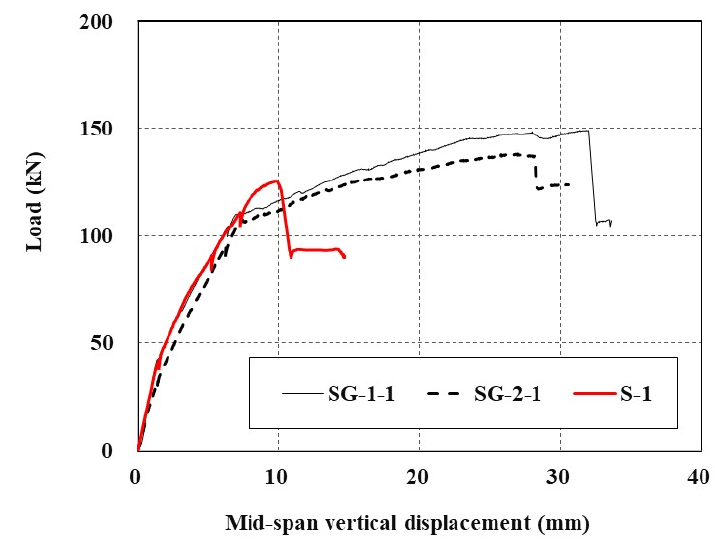
Figure 11. Comparison of load ‐ displacement curves of TRC strengthened slabs.